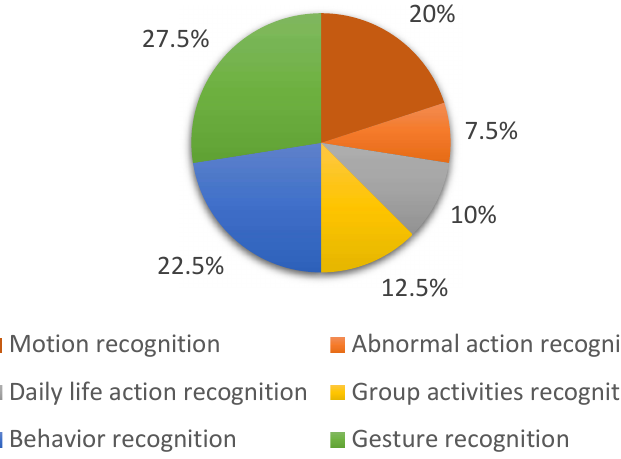
Figure 2. Distribution of studied types of human activities in the last ten